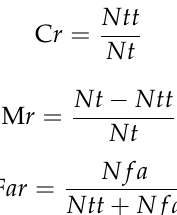
Table 2. Comparison in terms of the three measures.